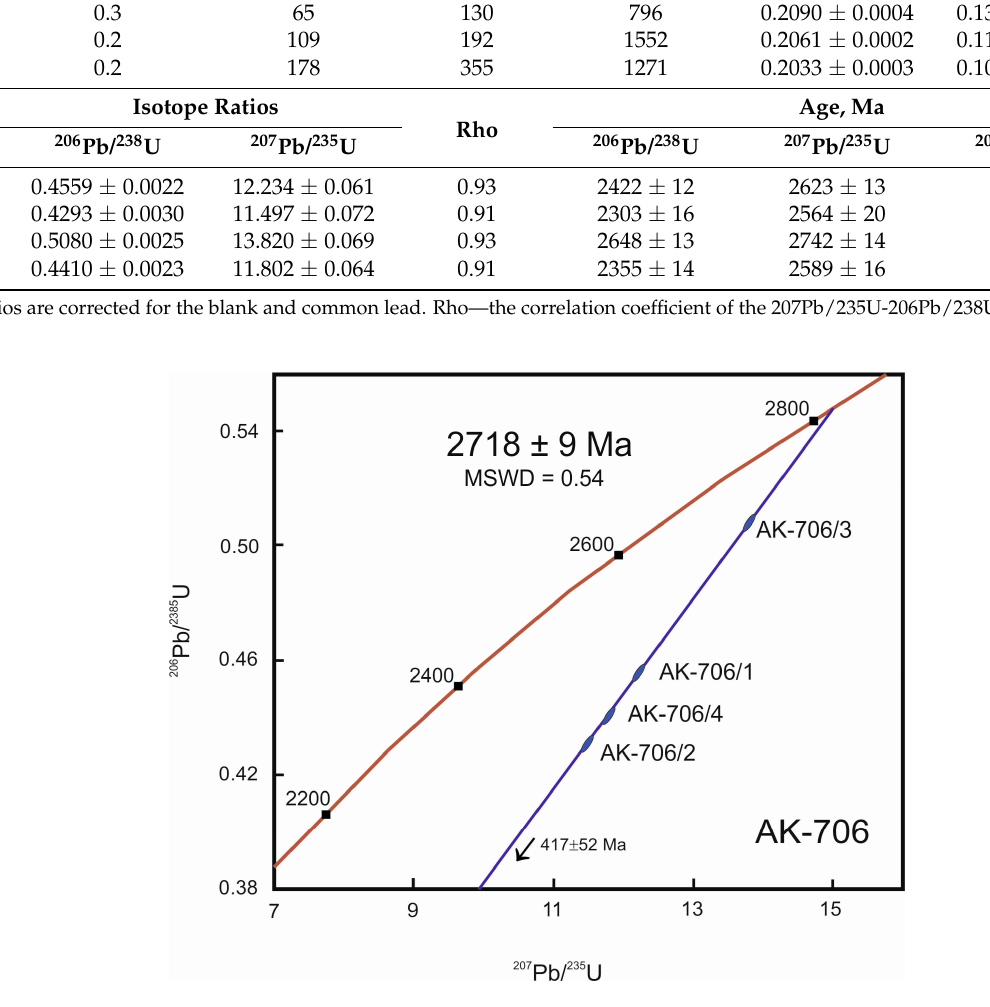
Figure 11. Diagram with concordia for granite porphyry from the Oleninskoe deposit.